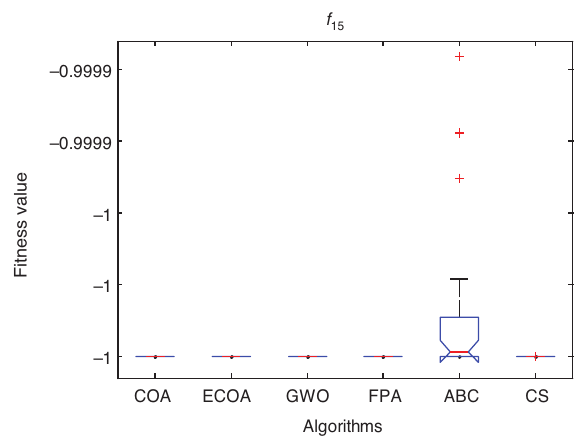
Figure 30: D = 2, ANOVA Test of Global Minimum for f